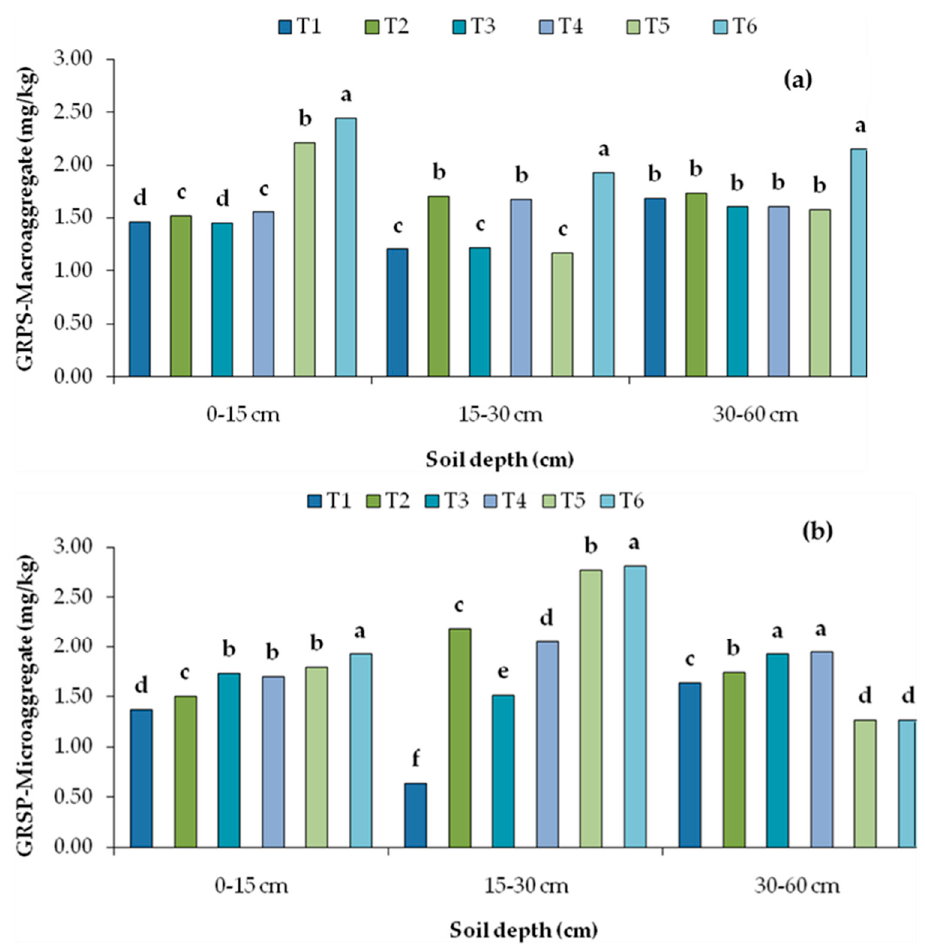
Figure 4. Depth-wise distribution of glomalin-related soil protein (GRSP) concentration in ( a ) macroaggregate (MA) and ( b ) microaggregate (mA), as affected by long-term organic agriculture. Note: T1, control without fertilization; T2, farmyard manure (FYM); T3, green manure (GM); T4, GM + biofertilizers (BF); T5, FYM +GM; T6, FYM + GM + BF. Letters represent significance of results among different treatments.